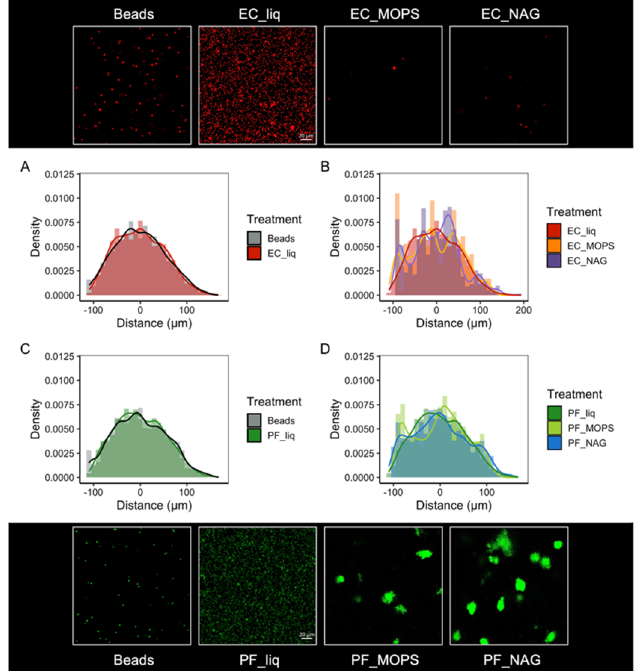
Figure 4 . Spatial organization of E. coli RFP (EC) and P. fluorescens GFP (PF) cells within single SSAs compared to liquid culture and 2 µm fluorescent beads. ( A, C ) Histogram of bead–bead or cell–cell distances within SSAs vs. (A) EC and (C) PF in liquid culture. ( B, D ) Histogram of distances between (B) EC or (D) PF cells in liquid culture vs. in SSAs with MOPS-only media (MOPS) or MOPS with 4-Methylumbelliferyl N-acetyl- β -D-glucosaminide (NAG), a chitin proxy. Representative images are shown for each treatment. All images are 212 µm x 212 µm. Note that color saturation, brightness, and contrast of some images is enhanced for visibility in this figure (see Supplemental Material). EC and PF images and beads are shown as individual channels of the same SSA region.